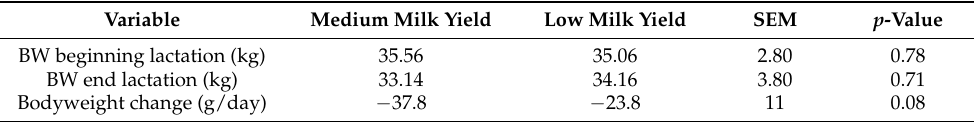
Table 1. Maternal body weight at the beginning and end of the experimental period and bodyweight change during lactation from goats at medium and low milk yielding potential.